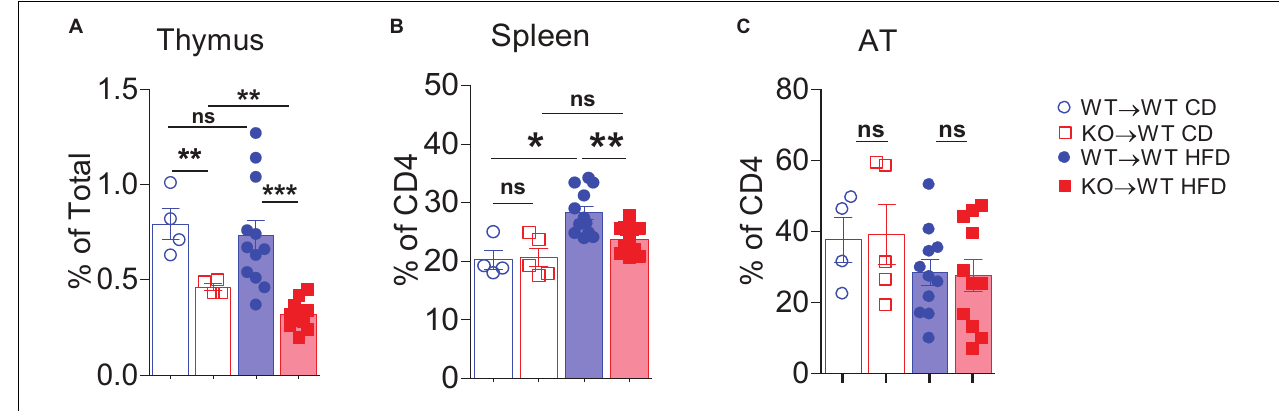
FIGURE 4 | Absence of March1 affects regulatory T cells in thymus and spleen but not in WAT. Thymocytes (A) , splenocytes (B), and SVF cells from WAT (C) of obese and lean WT → WT and KO → WT BMC were analyzed by flow cytometry. Tregs were identified as CD4 + Foxp3 + cells. ∗ P < 0.05 and ∗∗ P < 0.01.